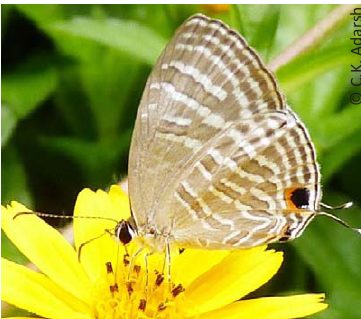
Image 69. Zizula hylax Tiny Grass Blue.